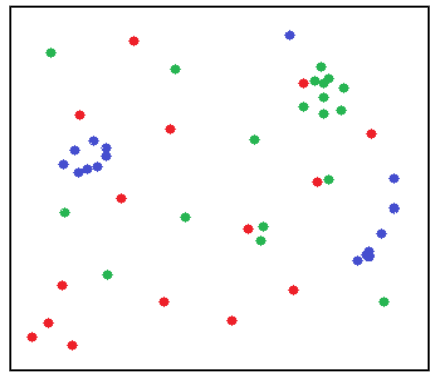
Figure 1. Single Landsat 8 pixel 30x30m that contains tens of crowd-sourced data points (Blue=>water, Green=> vegetation, Red=>built-up) and all resides within same pixel which leads to confuse the classifier and gives false predicted